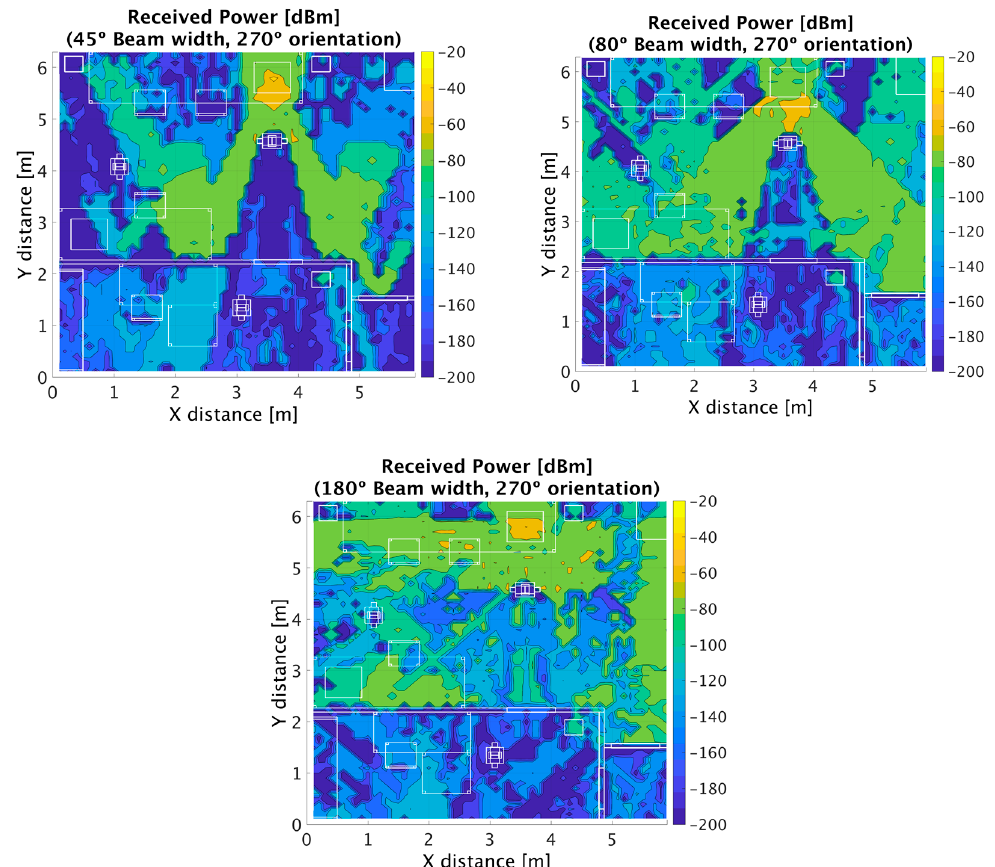
Figure 6. Simulated mmWave power distribution for outdoor coverage (at 28 GHz, beam width values of 80° and 20°, with 180° and 90° orientation), under simulation parameters defined in Table 2.